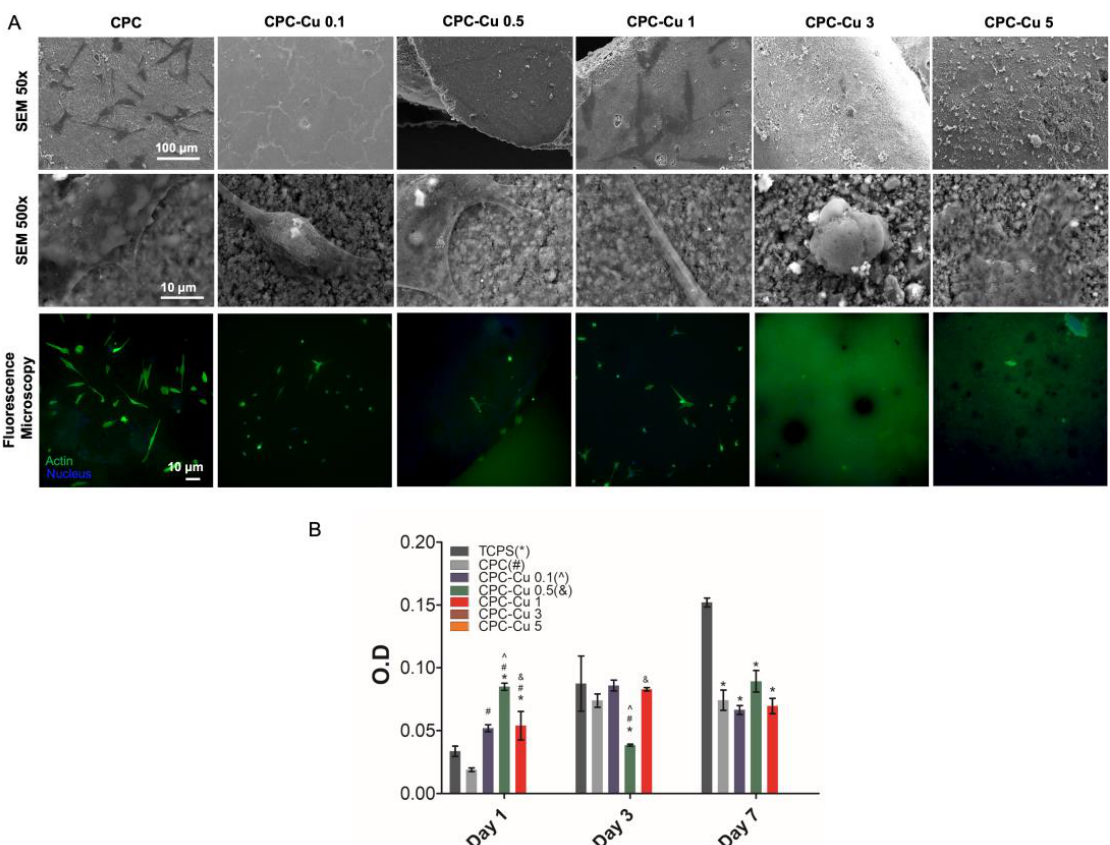
Figure 4. In vitro studies showing ( A ) cell attachment of hMSCs cells after day 1 incubation on CPC and Cu loaded CPC scaffolds showing changes in cell morphology with increased copper amounts in the scaffolds imaged under low mag SEM, high mag SEM, as well as fluorescence microscopy and ( B ) cell proliferation of hMSCs for day 1, 3, and 7 durations on CPC and Cu loaded CPC scaffolds showing improved cell proliferation with respect to time and no cell proliferation on scaffolds CPC-Cu 3 and CPC-Cu 5 groups. The data are represented mean ± standard deviation ( n = 3). The significance of difference p < 0.05 for various